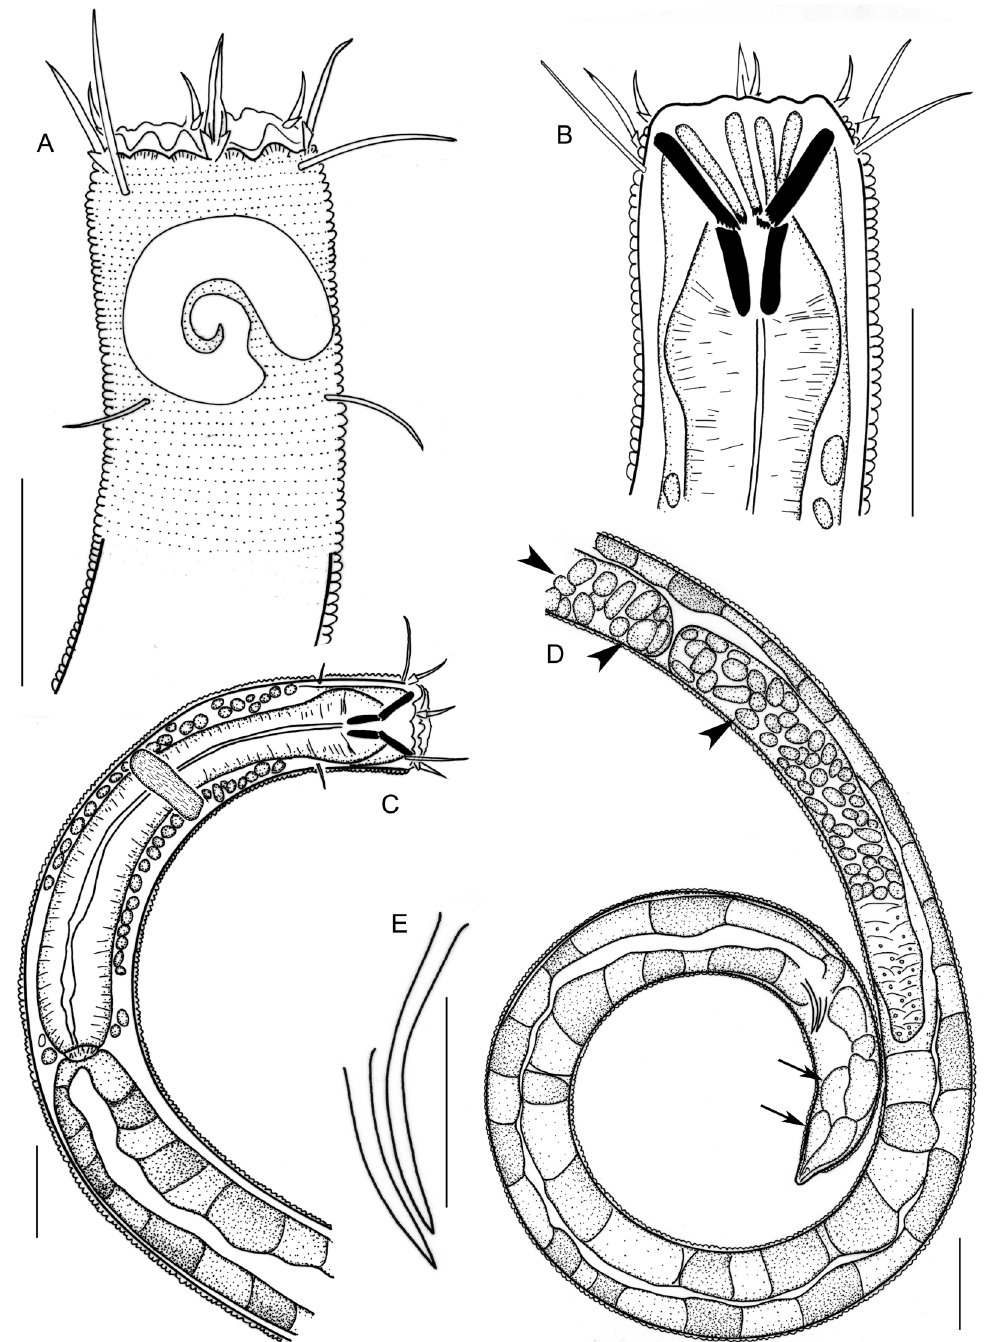
Fig. 1. Gammanema magnum sp. nov., holotype, ♂. A . Surface view of head, showing the very large amphideal fovea, six leaf-like outer labial setae, four slender cephalic and four slender cervical setae, and the transverse rows of punctuations. B . Inside view of head, showing the broad anterior buccal cavity reinforced by cuticularized rhabdia each with about six pointed denticles at the posterior end, the narrow and cylindrical posterior buccal cavity surrounded by six broad rhabdia, and the anterior pharynx swelling but not forming a bulb. C . Neck region, showing the pharynx surrounded by numerous cells, nerve ring, the large intestine cells filled of inclusions, and the irregular intestine lumen. D . Posterior region, showing the opposed testes with globular to oval sperm cells (arrowheads), the unequally long spicules, the caudal glands (arrows), and the short and conical tail. E . Two spicules. Scale bars: